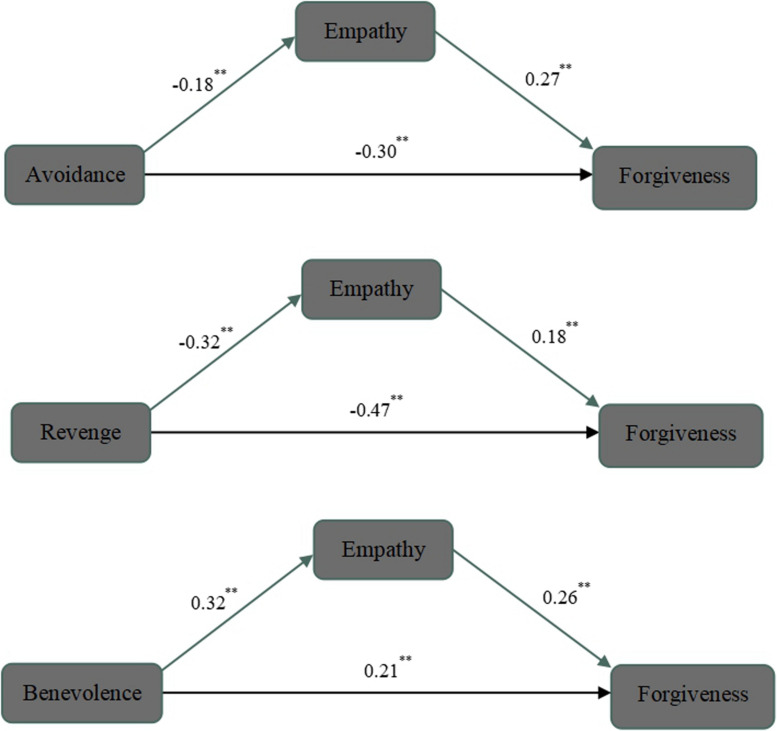
Mediation model.